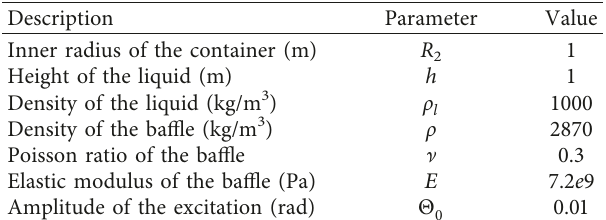
Table 2: The parameters for the baffled container in the steady- state